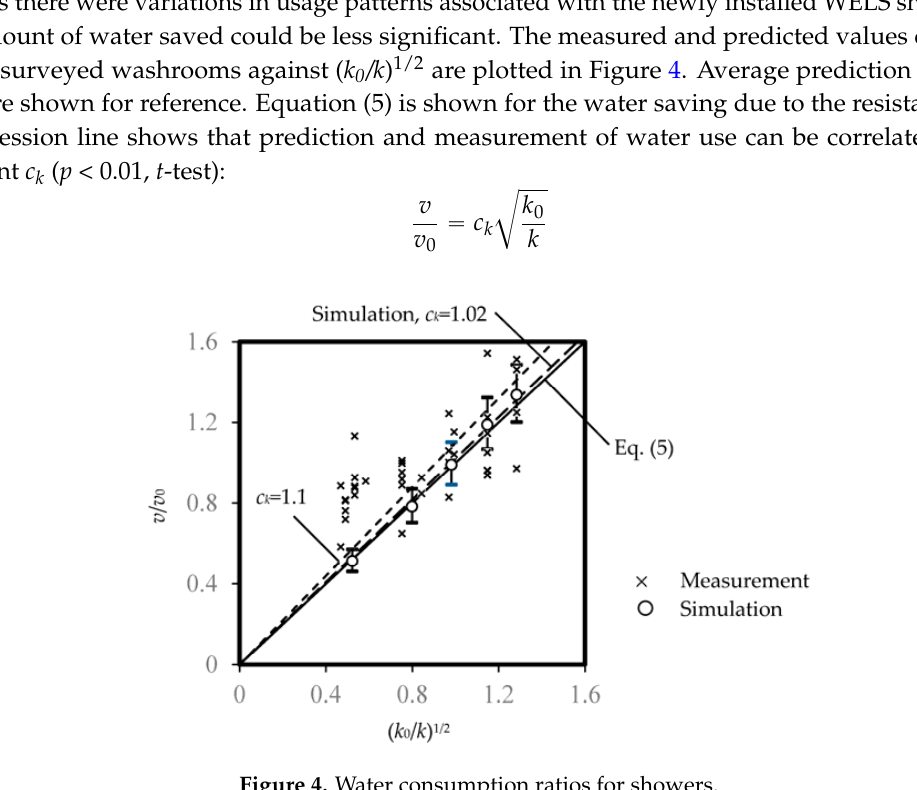
Figure 4. Water consumption ratios for showers.